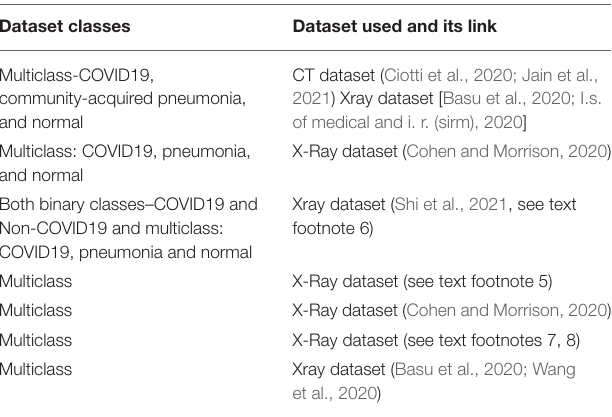
TABLE 2 | Dataset used in different survey